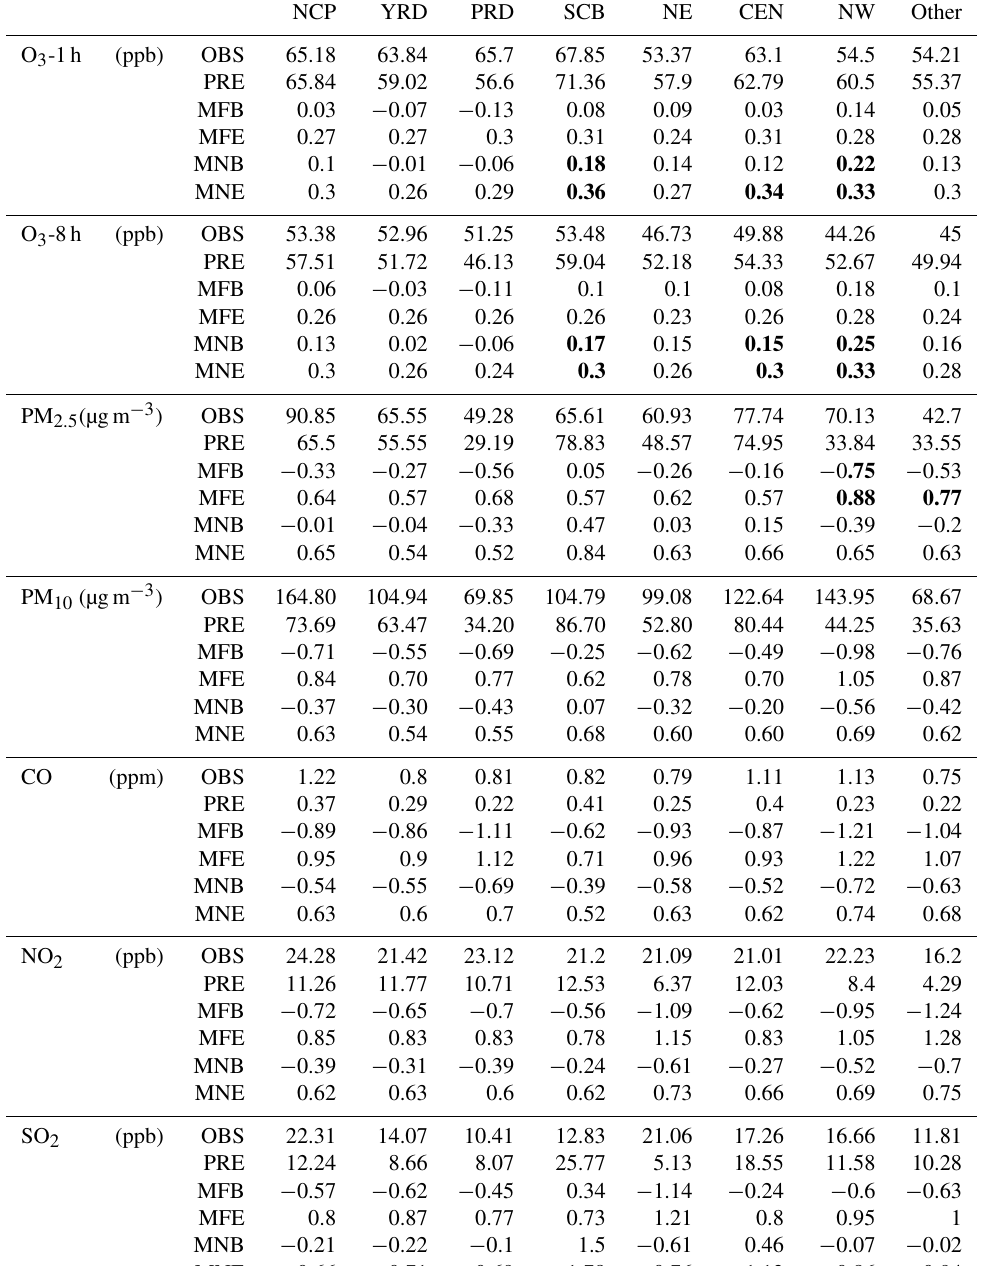
Table 4. Model performance on O 3 -1h, O 3 -8h, PM 2 . 5 , PM 10 , CO, NO 2 , and SO 2 in different regions during March to December 2013. The values that do not meet the criteria are denoted in